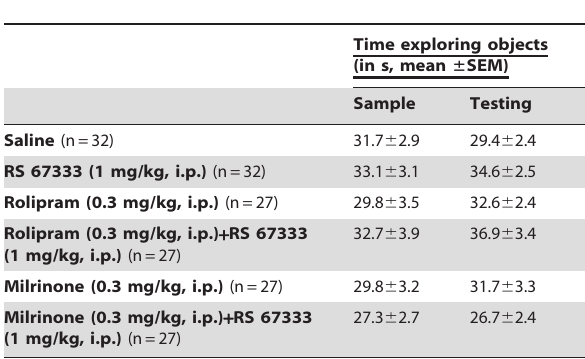
Table 1. Time of exploration of objects measured during the sample and the testing trails in the object recognition